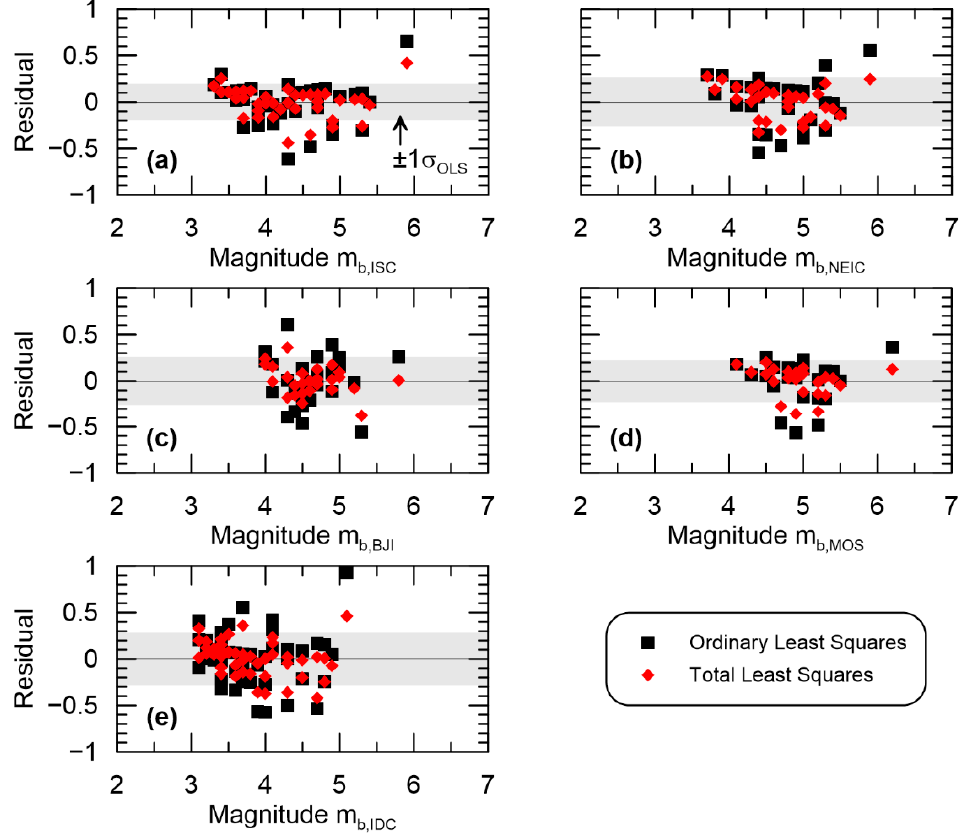
Figure 7. Regression residuals for m b from ( a ) ISC, ( b ) NEIC, ( c ) BJI, ( d ) MOS, and ( e ) IDC. The shaded regions represent ±1 σ from OLS regression.